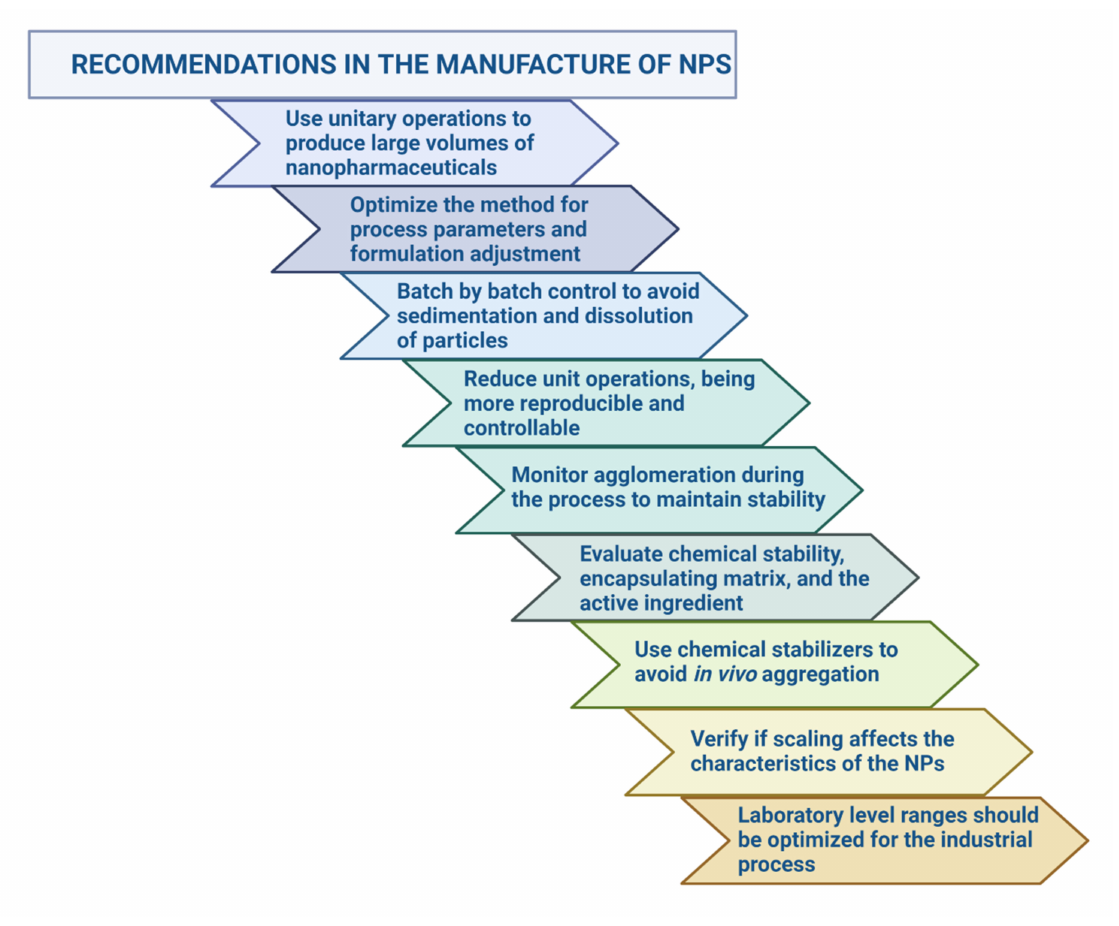
Figure 10. Recommendations for the manufacture of nanoformulations. Created with BioRender.com (accessed on 10 December